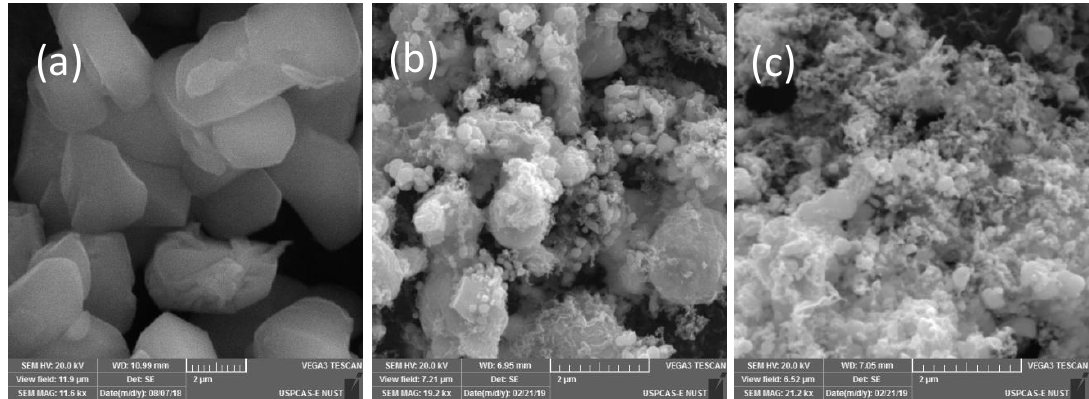
Figure 2. Scanning electron microscopy images of ( a ) Cu-tpa MOF, ( b ) Cu/NC, ( c ) CuPt/NC .